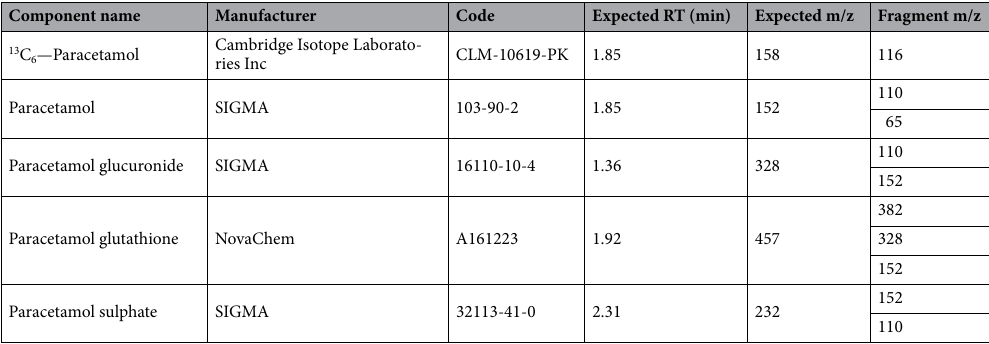
Table 1. Compound and protocol information for paracetamol UPLC–MS/MS analysis. The compound being analysed (component name) and relevant manufacturer information is detailed along with column retention time (RT) and the mass to charge ratio (m/z) for the parent and fragment ions. The m/z transition: m/z 158 > 116, m/z 152 > 110, m/z 328 > 152, m/z 457 > 328 and m/z 232 > 152 were used for quantitative analysis of 13 C 6 -paracetamol, paracetamol, paracetamol glucuronide, paracetamol glutathione, and paracetamol sulphate respectively, while other transitions were used as